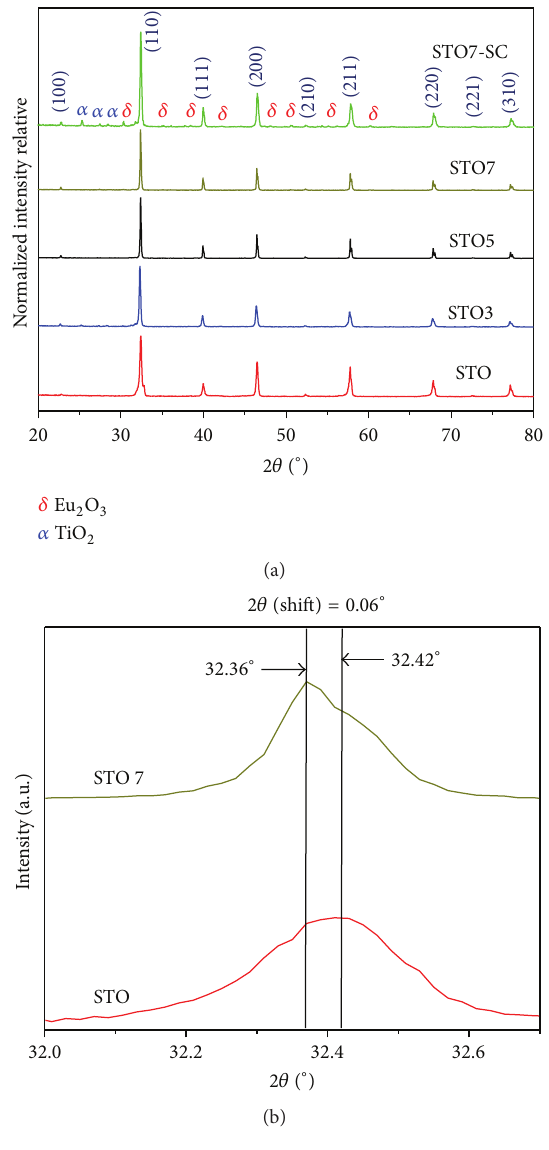
Figure 2: (a) XRD patterns of (a) STO, STO3, STO5, and STO7 phosphors. (b) shows the diffraction peaks associated with the plane (110) for samples STO and